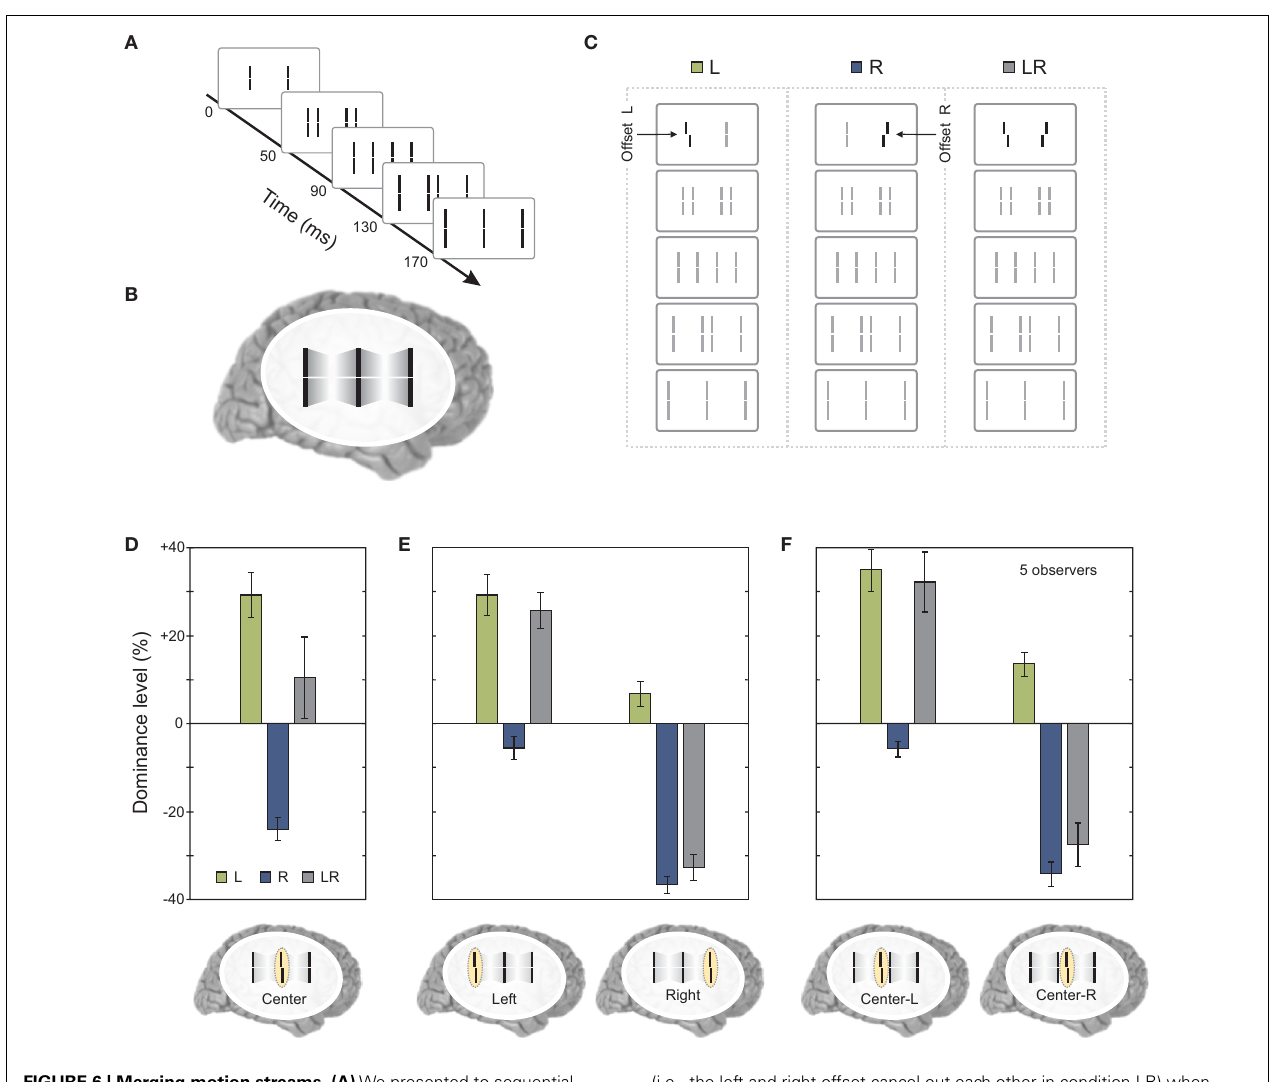
FIGURE 6 | Merging motion streams. (A) We presented to sequential metacontrast sequences (see Figure 1 ) next to each other so that two motion streams terminated in a common line. (B) The percept of two merging motion streams is elicited. (C) In three conditions, the left, the right, or both lines in the first frame were offset. All flanking lines were non-offset. (D) Offsets from the left and right sequence were combined